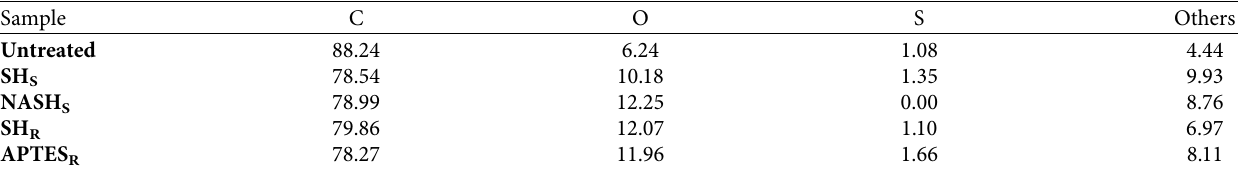
Table 2: Te EDX derived atomic percentage of the untreated and treated